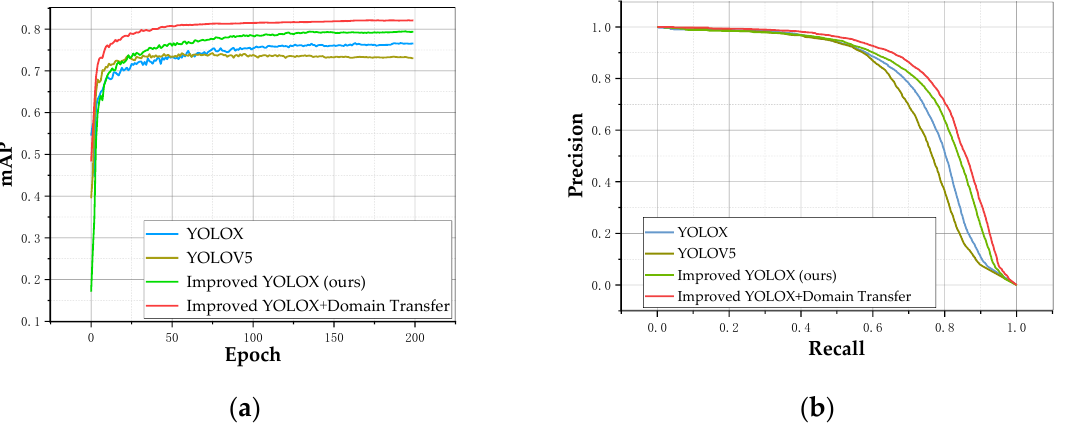
Figure 6. ( a ) Comparison of mAP for different algorithms. ( b ) Comparison of PR curve for different algorithms.